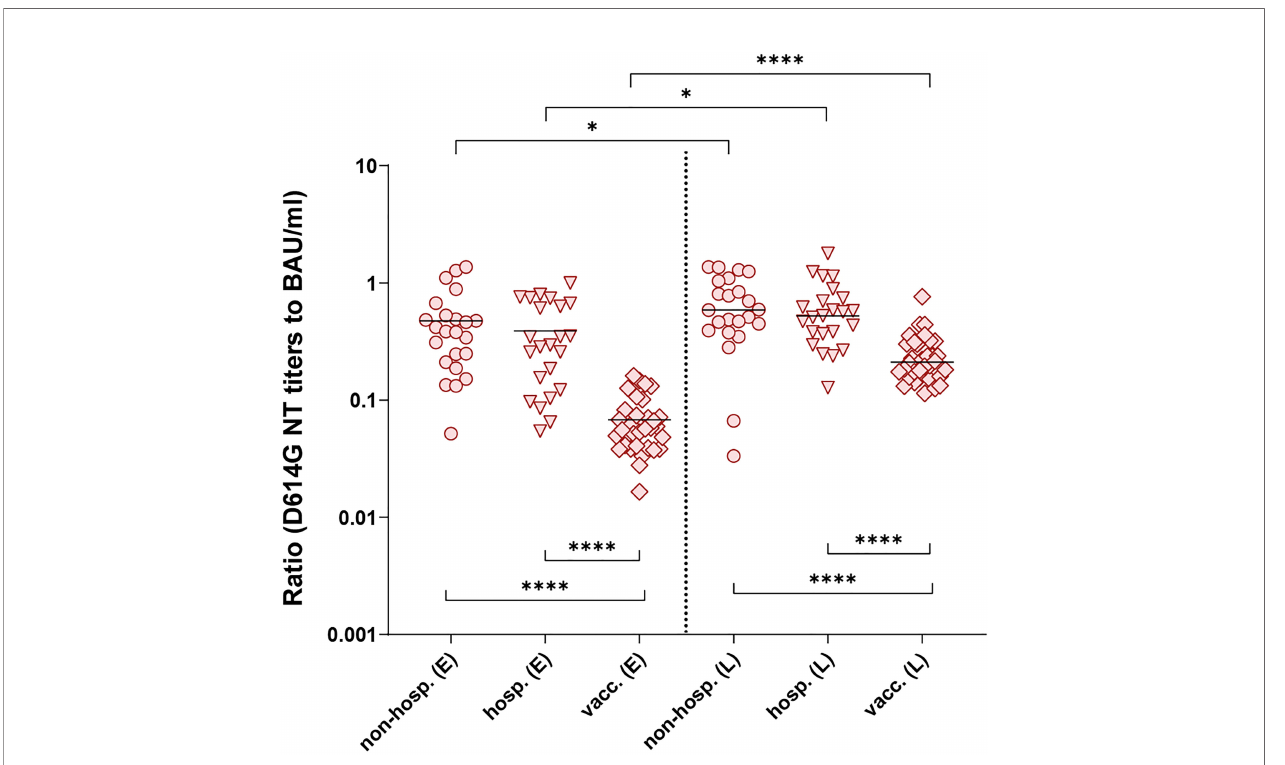
FIGURE 5 | Ratios of D614G virus NT titers and ELISA concentrations of individual serum samples after infection (non-hospitalized and hospitalized patients) and two doses of the mRNA vaccine BNT162b2. Only NT- and ELISA-positive samples were included. Early samples (E) were taken approximately three weeks after disease onset or the second vaccine dose; late samples (L) approximately six months after disease onset or the second vaccine dose. Bars indicate the mean. Statistical analysis was performed with ANOVA and Tukey ’ s multiple comparison ’ s post hoc test (comparison of cohorts, bottom brackets) and paired t-test (comparison within groups, top brackets). Asterisks indicate statistical signi fi cance: (*) = P ≤ 0.05, (****) = P ≤ 0.0001. non-hosp., non-hospitalized patients; hosp., hospitalized patients; vacc., vaccinees.